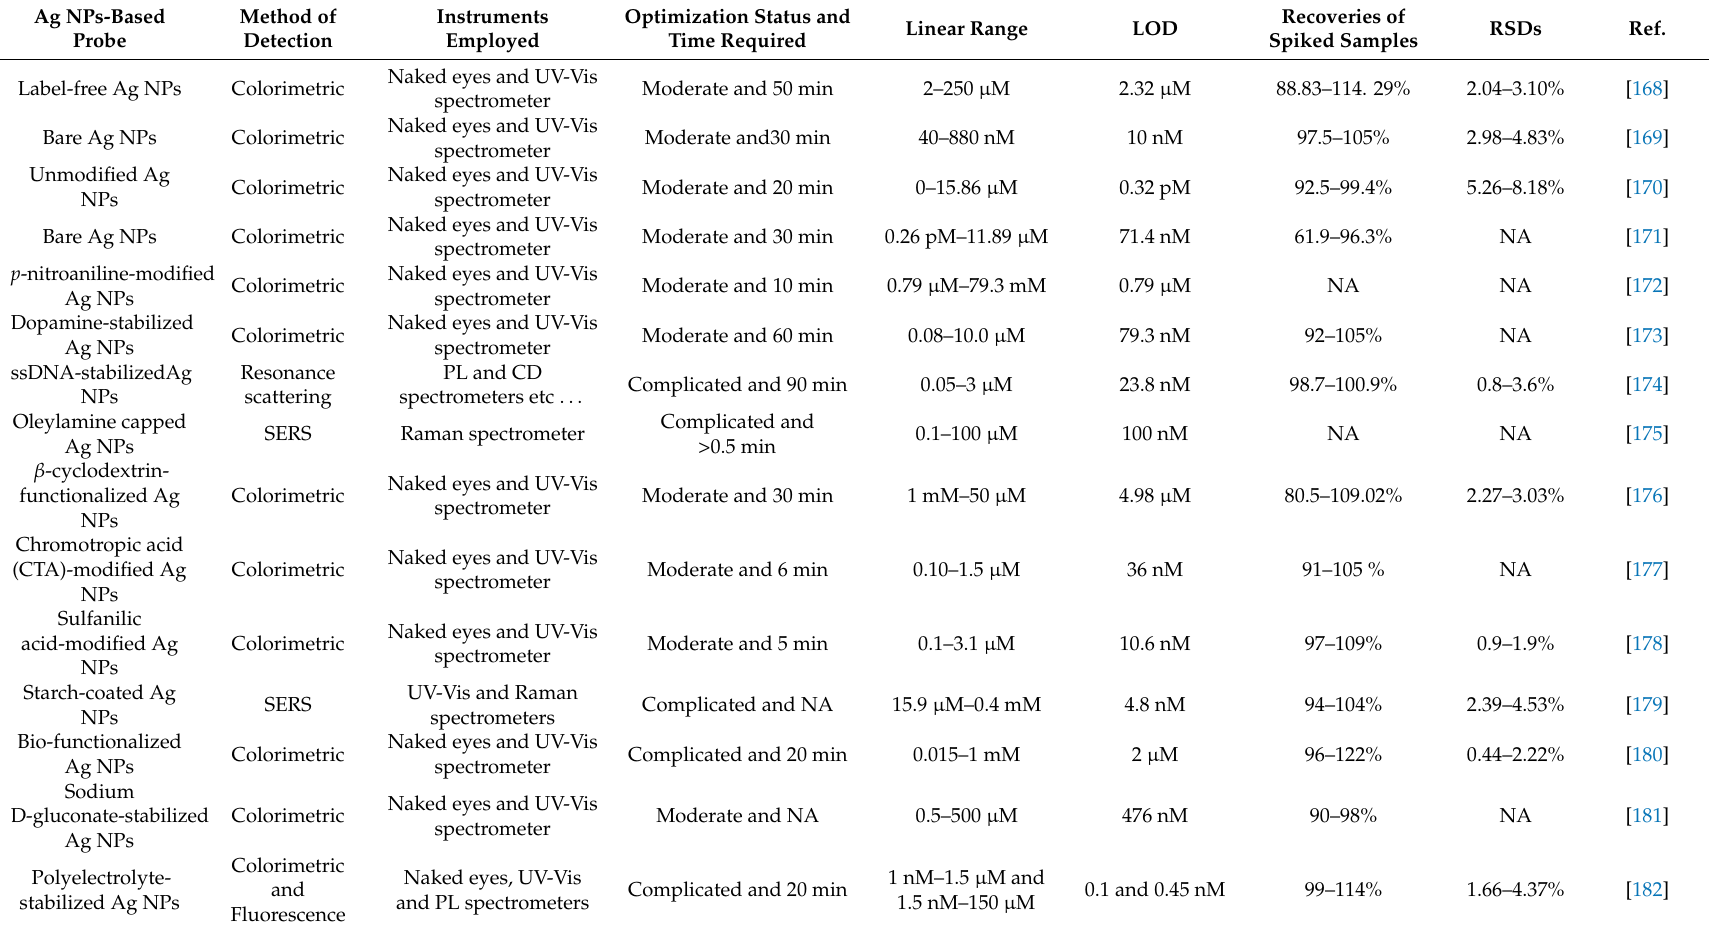
Table 2. Summary of methods, instruments, optimization status, time, linear ranges, detection limits (LODs), recoveries and relative standard deviations (RSDs) of Ag NPs-based probes in melamine